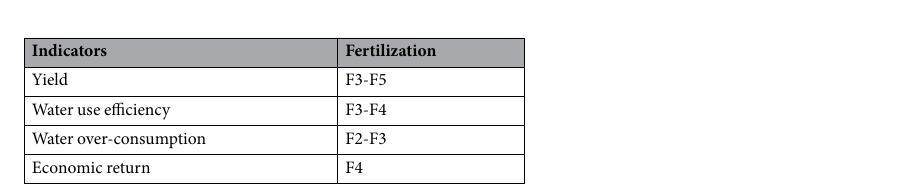
Table 2. Recommended fertilizer amount for apple orchards in Luochuan based on different statistical